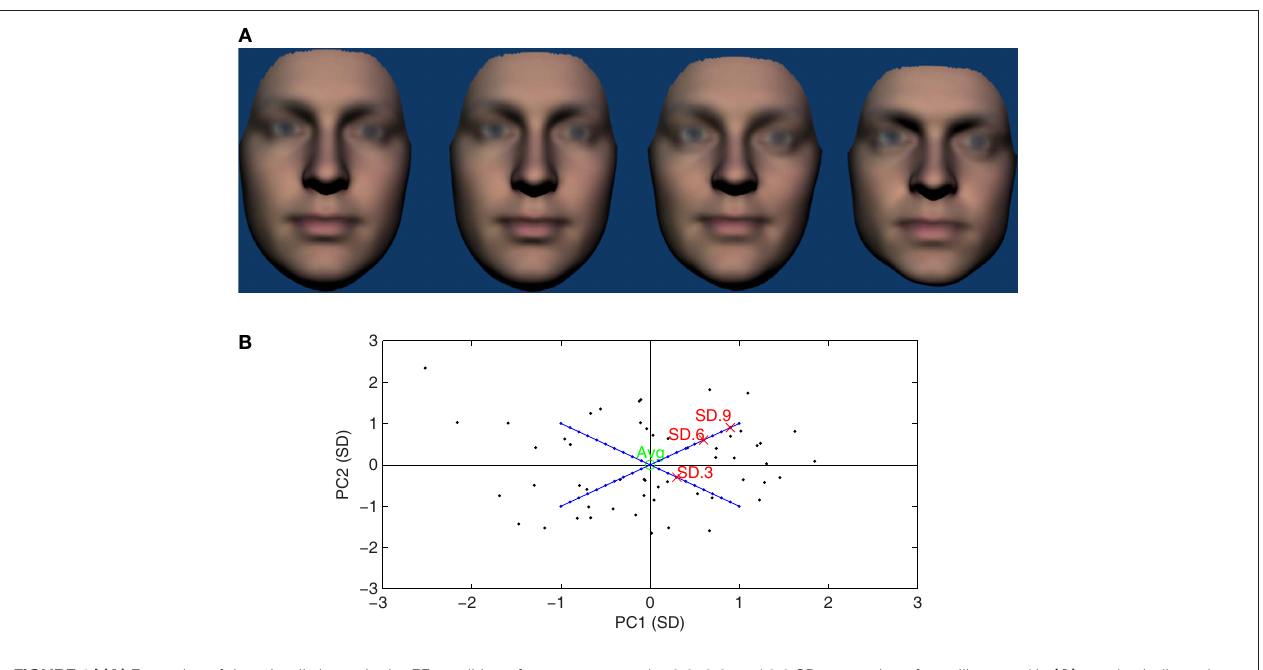
Figure 1 | (A) Examples of the stimuli shown in the FF condition of Experiment 1. From left to right, the average reference face and 0.3, 0.6, and 0.9 SD comparison faces. The P50 observed in this condition was 0.33 SD, just to the right of the second face from the left. (B) Two-dimensional illustration of face-space used for Experiment 1. Black points show locations of the 54 faces used to define the face-space. The locations of the average reference face and